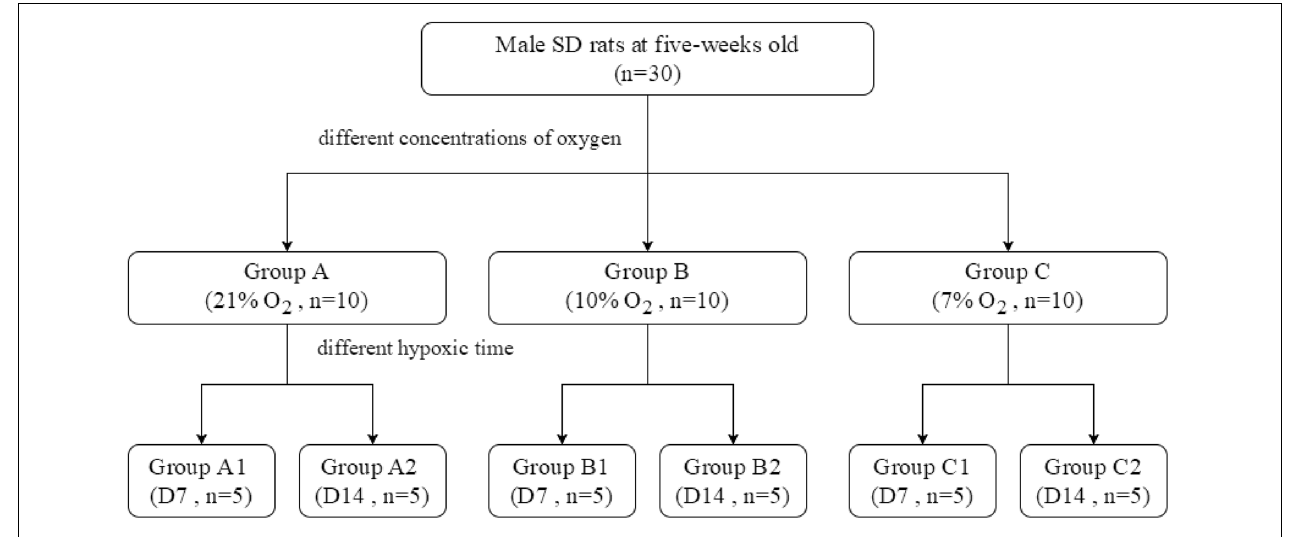
FIGURE 1 | The design of animal experiments.